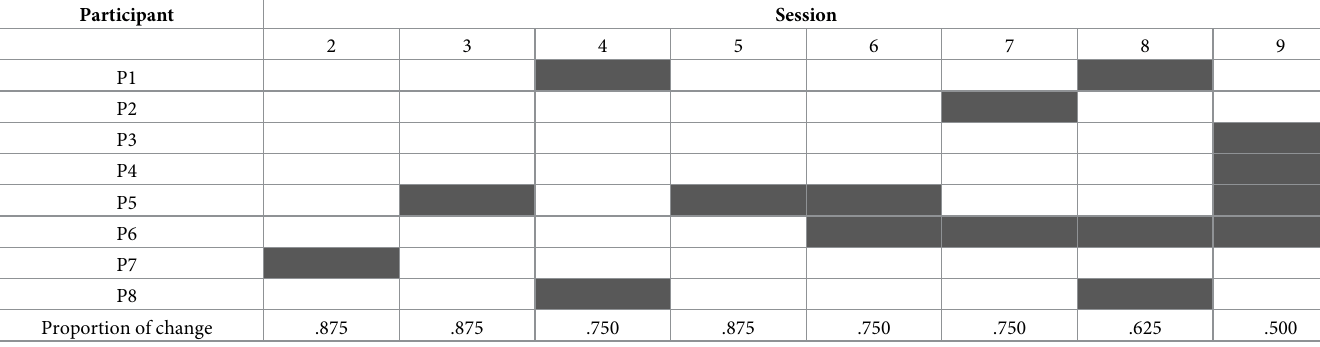
Table 2. Practice schedule of the participants in the SVG. Participant Session